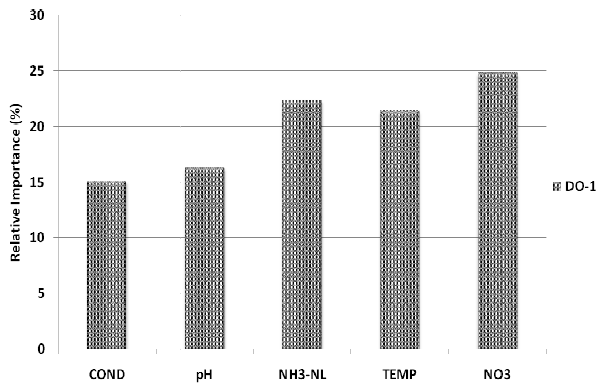
non-homogenous nature of water quality parameters.